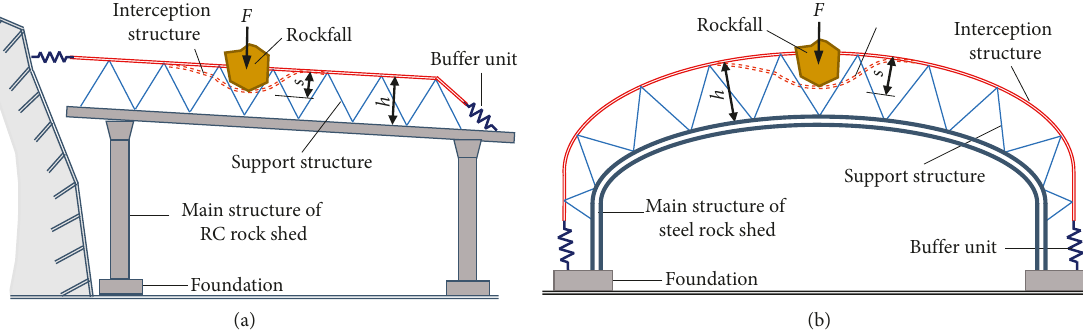
Figure 6: Composite rock sheds. (a) Buffer structure mounted on an RC rock shed. (b) Buffer structure mounted on a steel rock